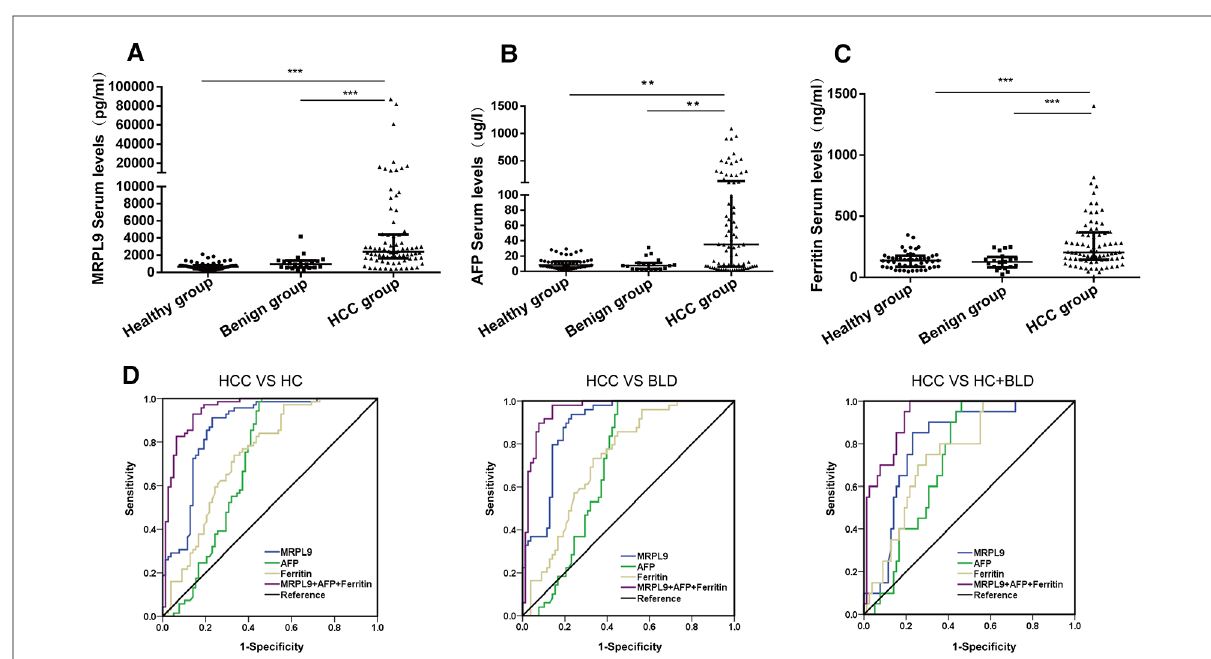
FIGURE 8 Serum MRPL9, AFP and ferritin levels in the healthy, benign liver disease, HCC groups and ROC curves. ( A – C ) MRPL9, AFP and Ferritin serum levels in healthy, benign liver disease and HCC groups, respectively. ( D ) ROC curves were constructed to predict the diagnostic accuracy of MRPL9 for distinguishing HCC patients from non-HCC subjects, healthy group and benign liver disease group, respectively.